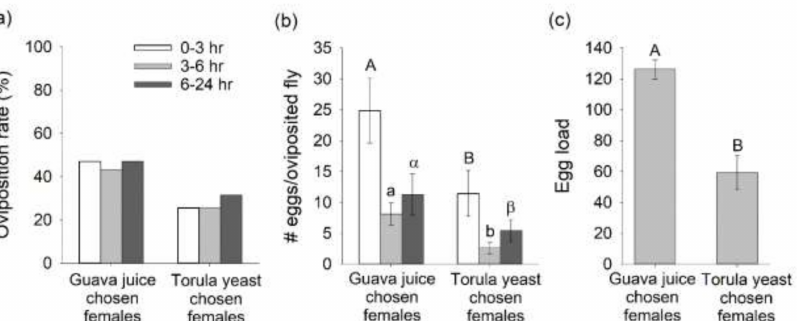
Figure 5. Oviposition responses ( a , b ) and egg load ( c ) from mated female Bactrocera dorsalis immedi- ately after individual female flies made a choice between guava juice or torula yeast. Oviposition responses were evaluated at 0–3, 3–6, and 6–24 h post-choice period. Different letters indicate significant difference between guava juice and torula yeast by Tukey–Kramer tests at p <